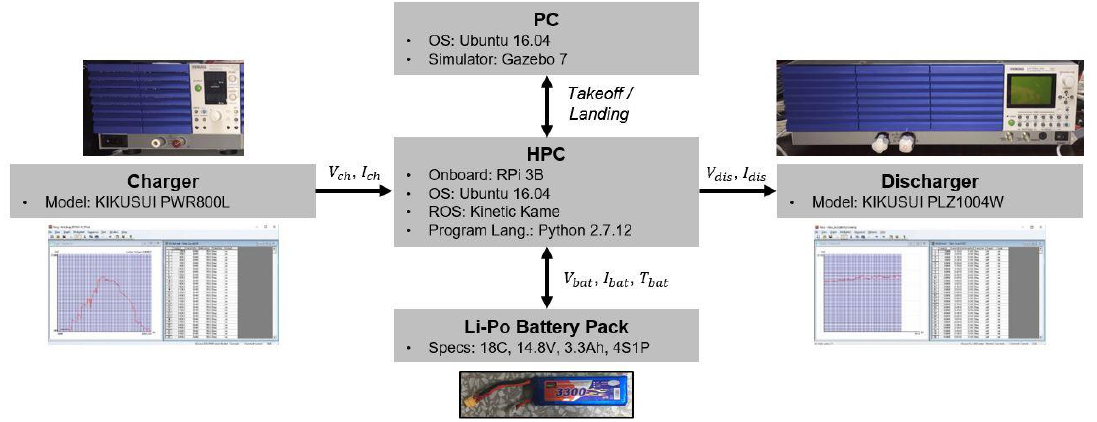
Figure 10. Indoor hardware-in-the-loop (HIL) test setup.